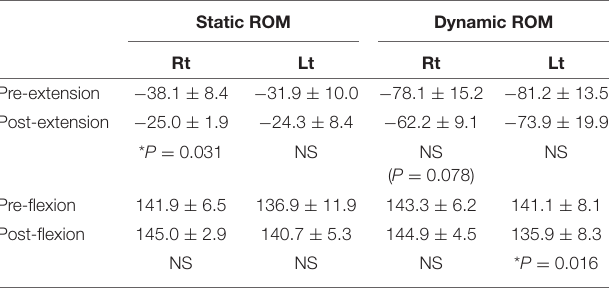
of each muscle was evaluated by EMG collected at 2,000 Hz and filtered using passing filter with a bandwidth of 30–400 Hz.